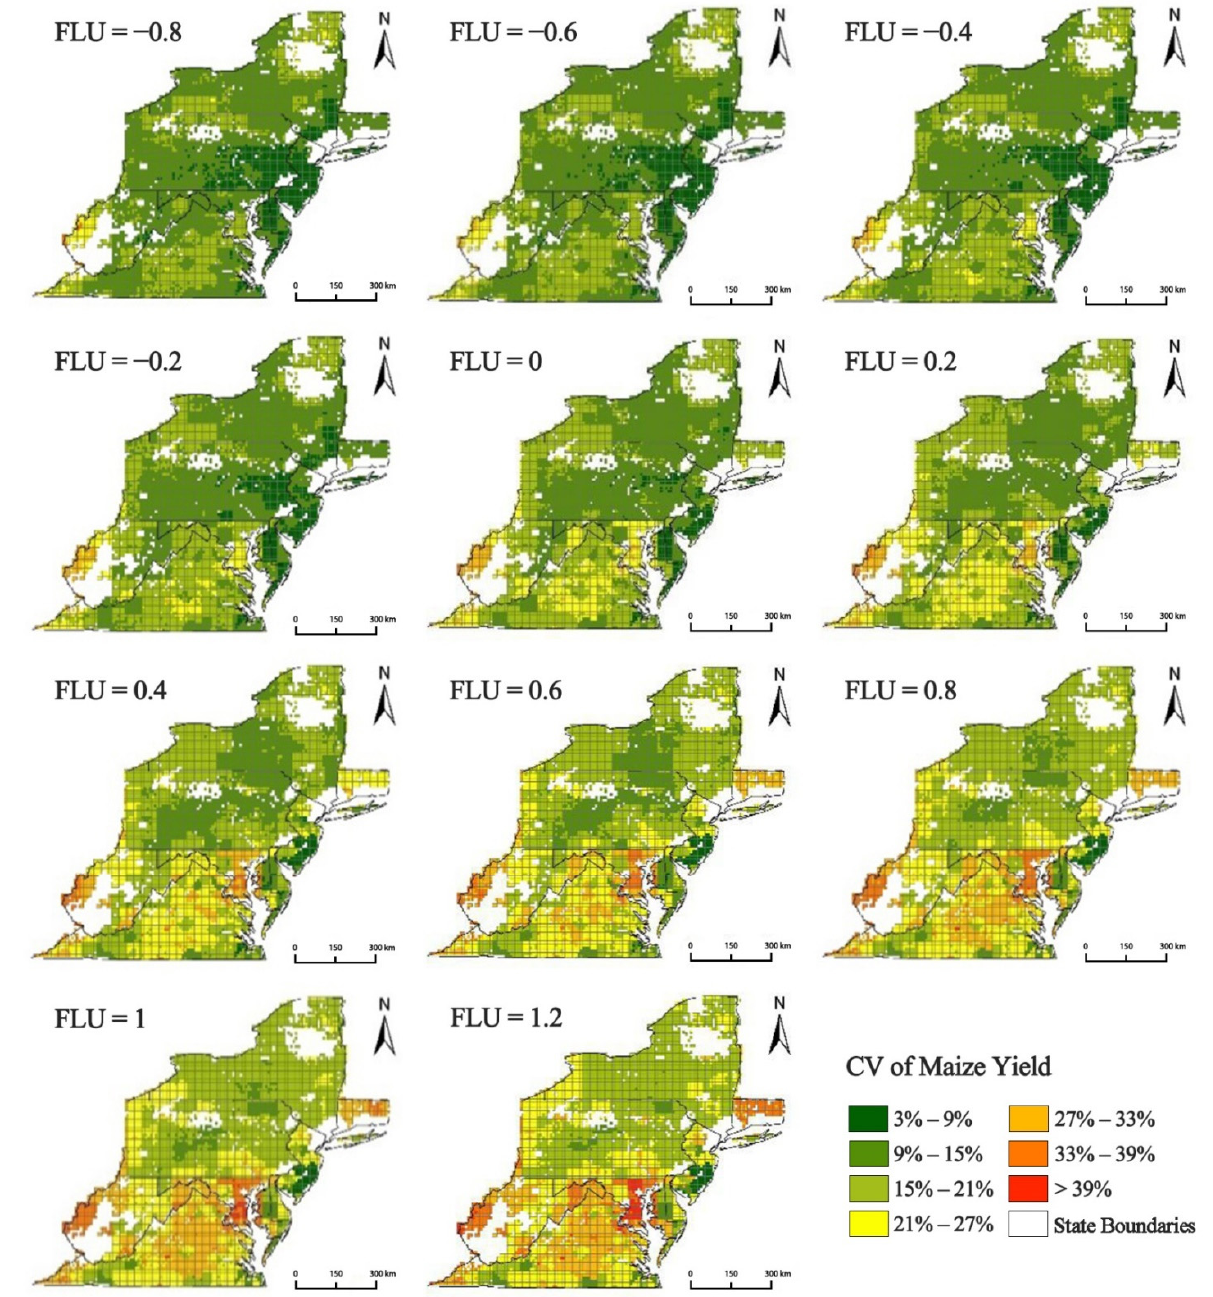
Figure 6. Distribution of CV of maize yield on each FLU level in the study area.